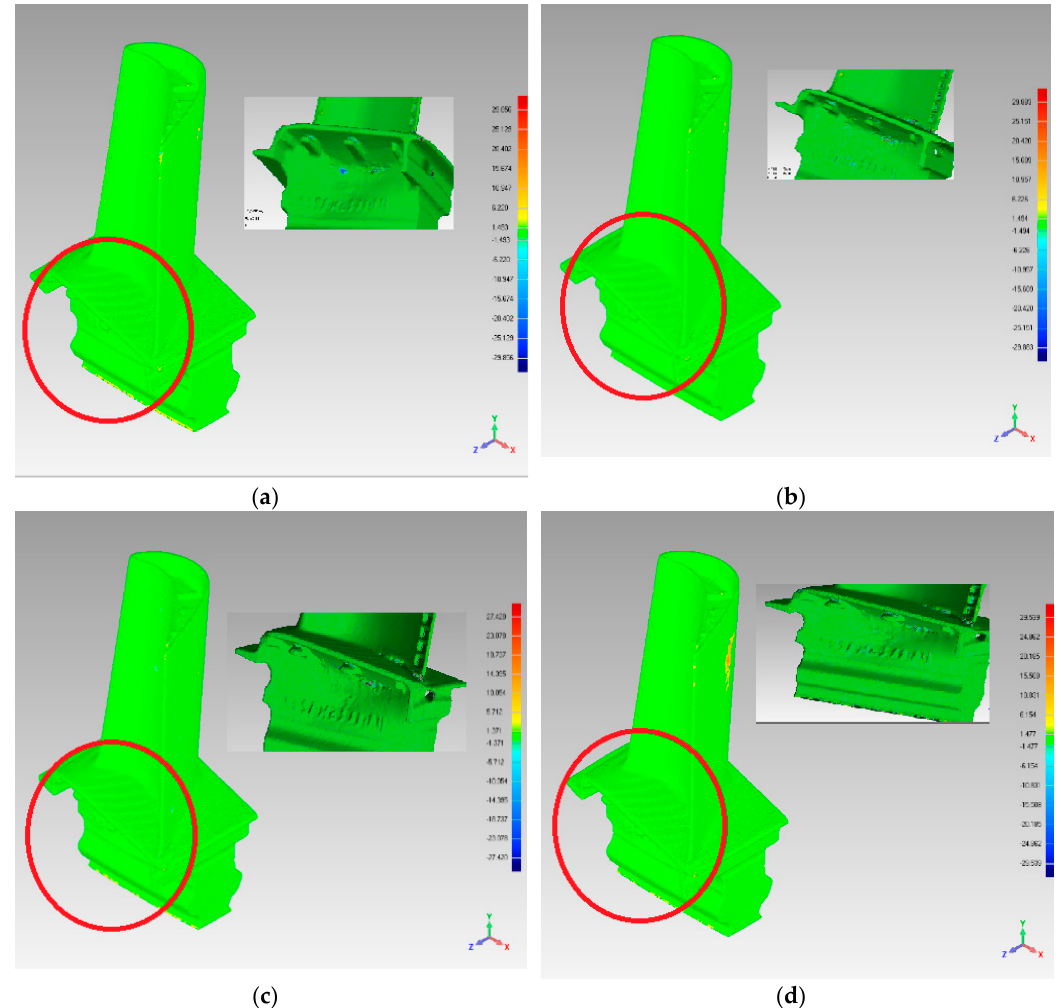
Figure 15. Simplification effect comparison of four simplification algorithms using the Fandisk data set: ( a ) uniform-based simplification algorithm; ( b ) grid-based simplification algorithm; ( c ) curvature- based simplification algorithm; ( d ) FPPS.